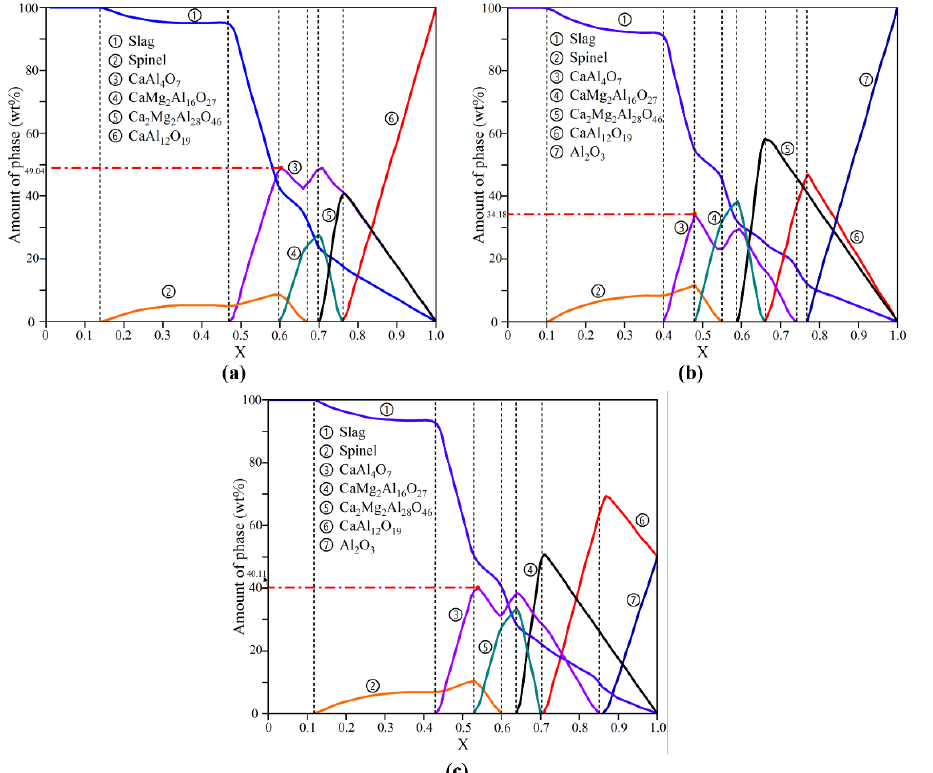
Figure 10. The thermodynamic simulation results of three crucibles: ( a ) CA 6 crucible, ( b ) Al 2 O 3 crucible, and ( c ) CA 6 -Al 2 O 3 crucible.